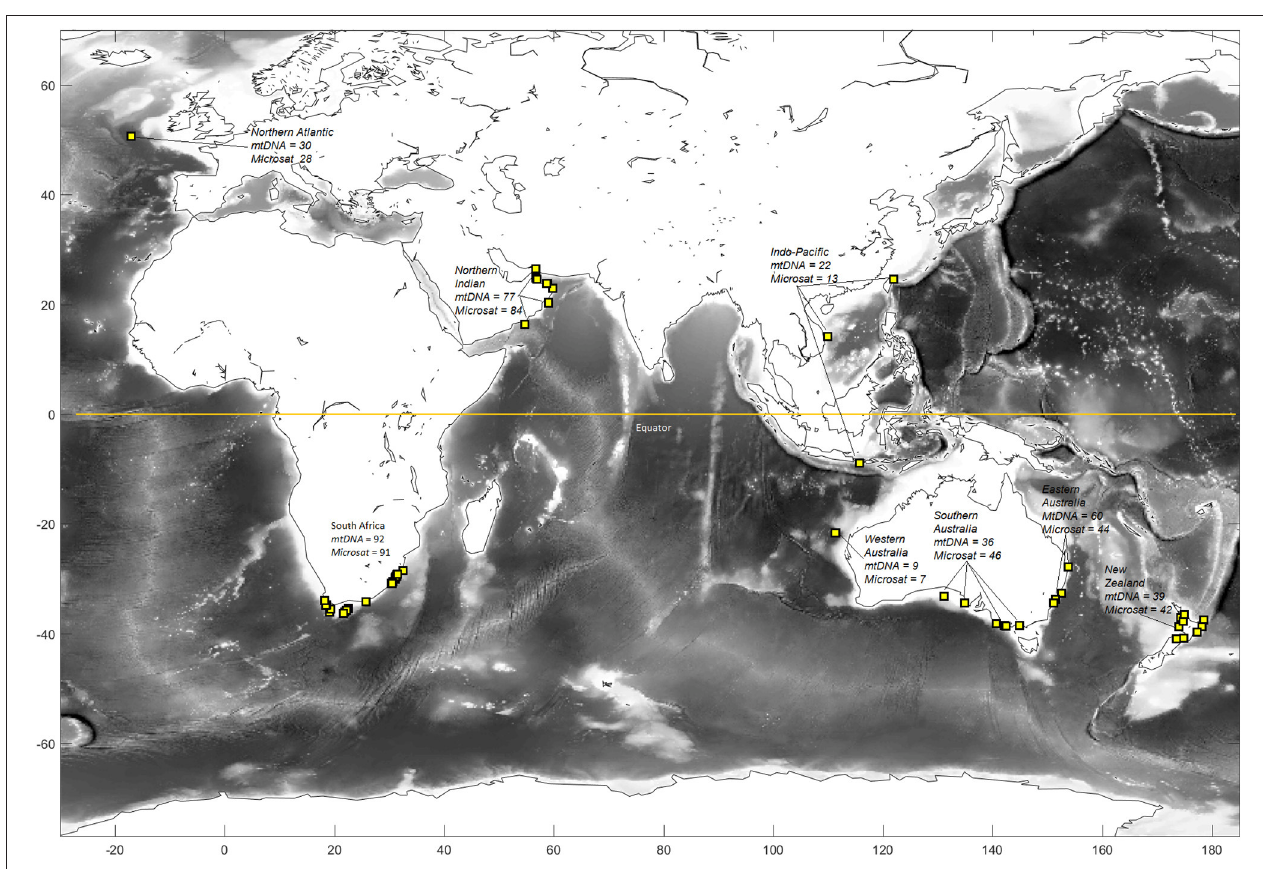
FIGURE 1 | Sampling locations and sample sizes of shortfin mako for genetic analyses. Regions include the Northern Atlantic, South Africa, Northern Indian, Western Australia, Indo-Pacific, southern and eastern Australia, and New Zealand. Western and southern Australia were grouped to comprise southwestern Australasia and the Indo-Pacific and eastern Australia were grouped to comprise eastern Australia for some